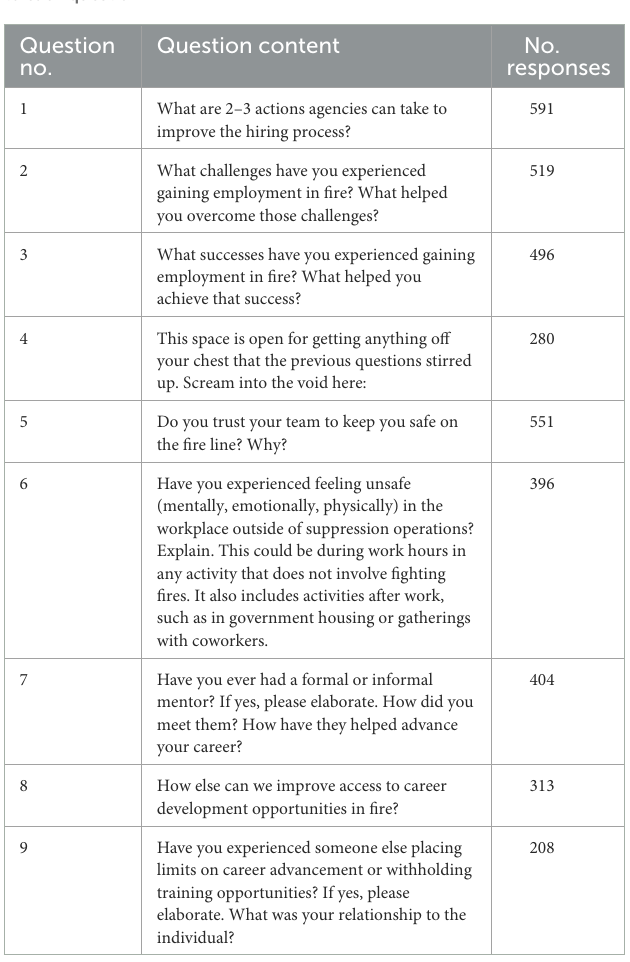
TABLE 1 Questions posed during the survey in the sequential order in which they were presented and the total number of individuals responding to each